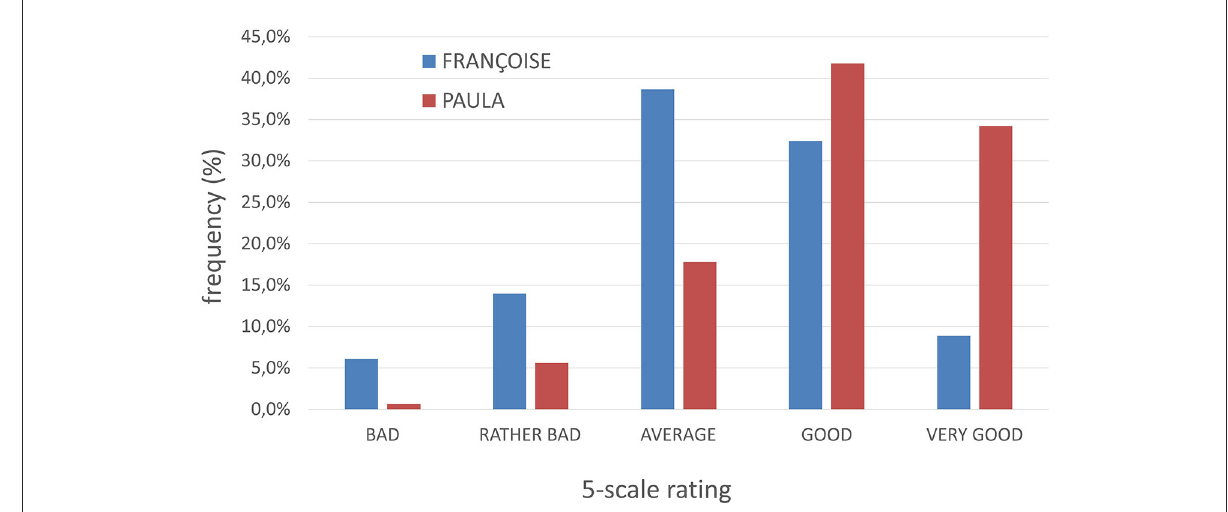
FIGURE5 Frequency distribution (%) of avatar preference for all signing occurrences (bar plot).